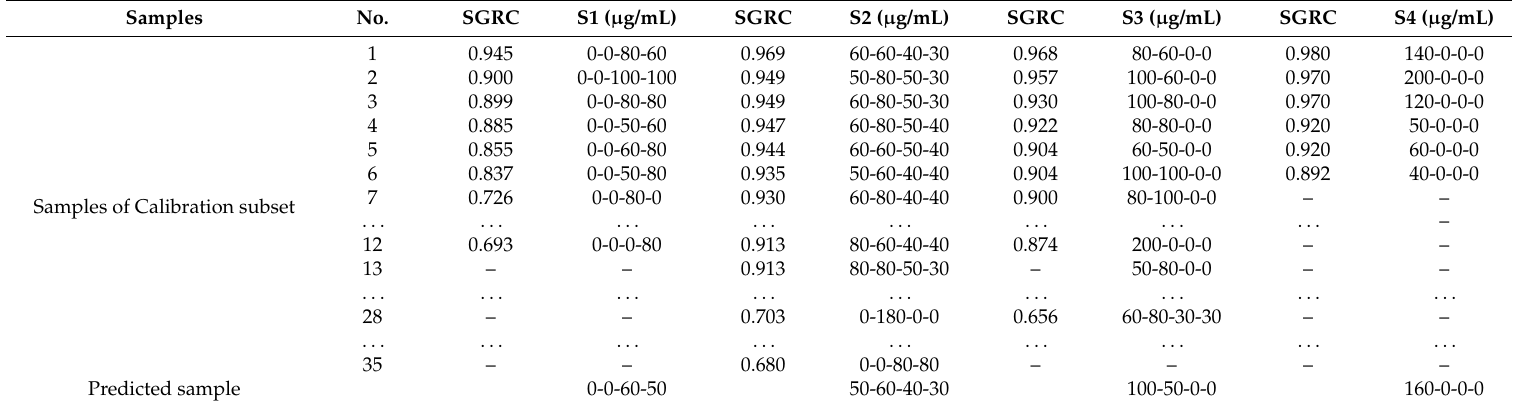
Table 2. The concentrations of each sample in calibration